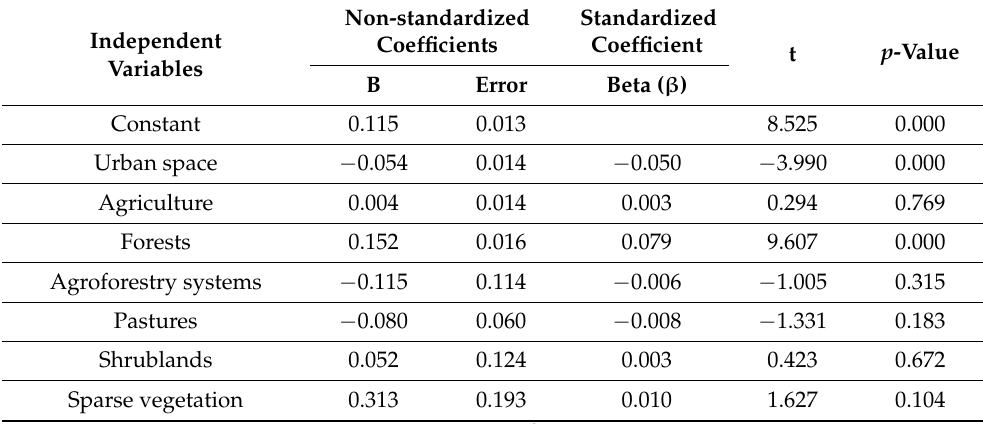
Table 5. Summary of significance of land use explanatory variables (COS, 2015) in the multiple regression. Independent